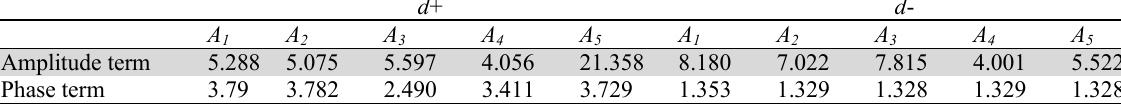
The separation measures of each point to PIS and NIS